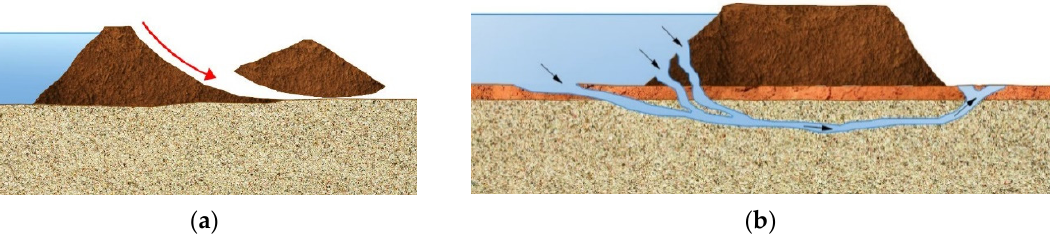
Figure 1. Levee failure mechanisms analysed in the study: slope instability ( a ) and internal erosion ( b ).